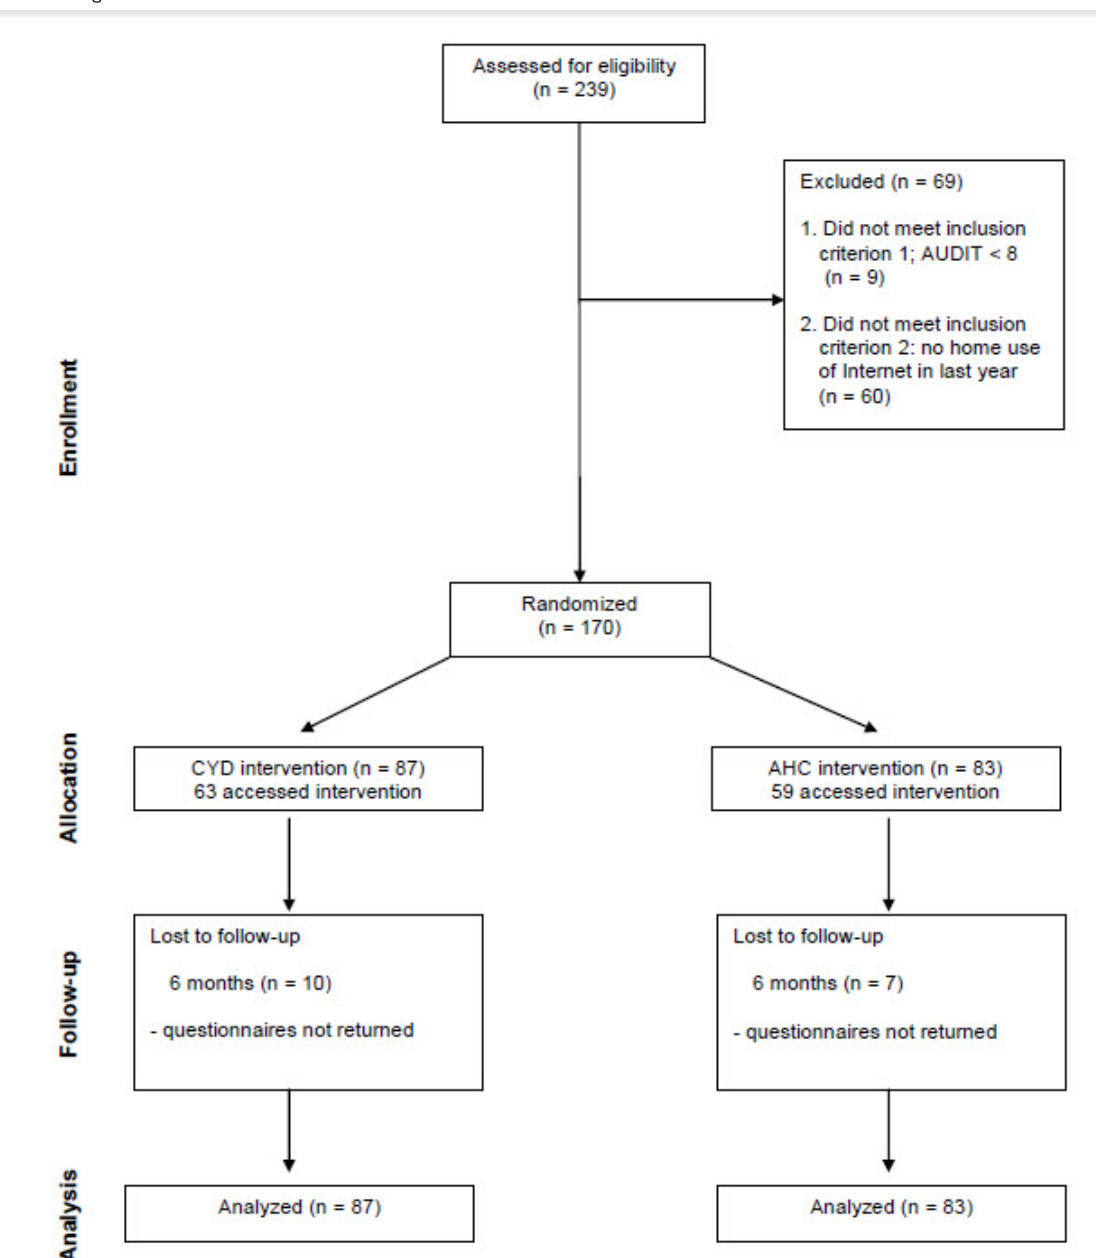
Figure 1 for a CONSORT diagram of the trial.